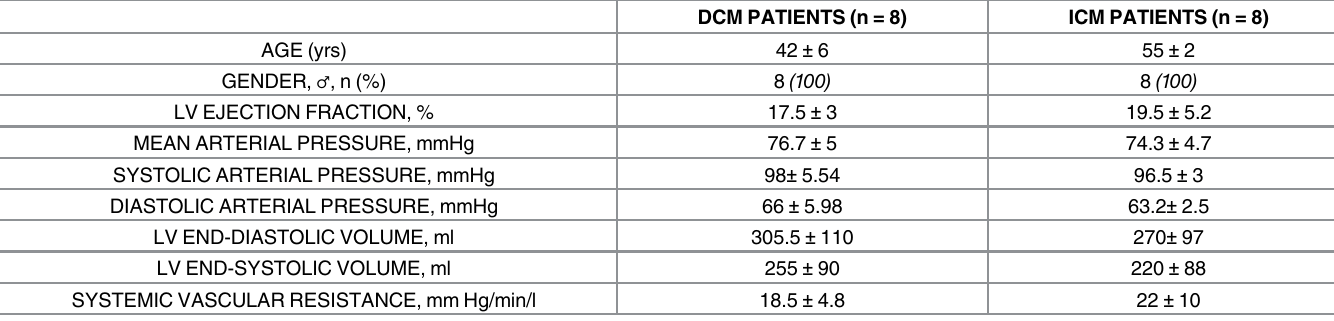
Table 1. Biochemical characteristics of DCM and ICM